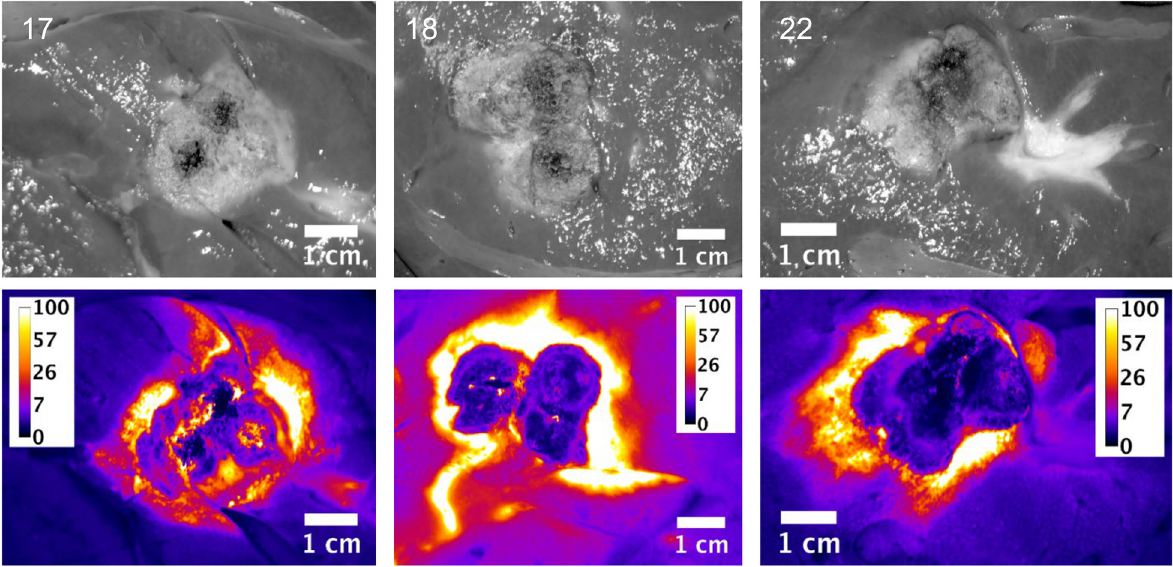
Fig 8. Plain and fluorescent images of ablation zone in pigs in Study C group 2. Each pig received three sequential, overlapping 12 minute ablations and 3 minute cool down between ablations (total time = 45 minutes) with the Angiodynamics device. Scale is μ g/g doxorubicin.